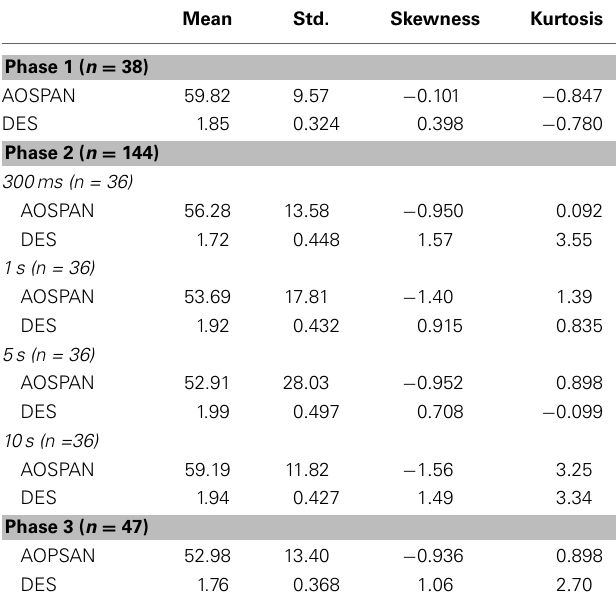
Table 1 | Distribution of Individual